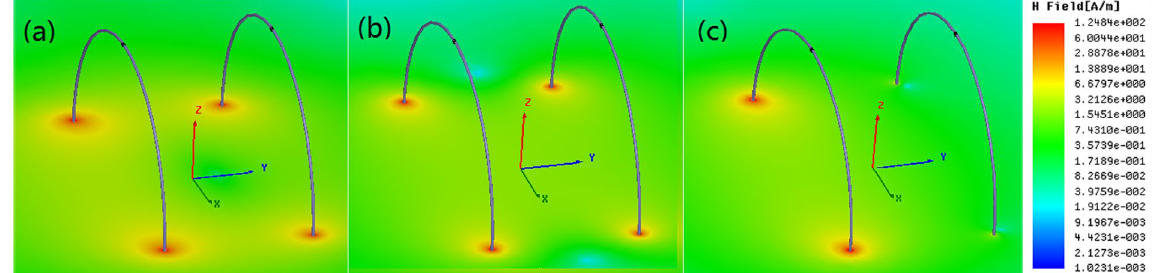
Figure 2. Incident and reflected magnetic field magnitude distributions. ( a ) The input port has a 10 Ω resistance, and the output has a 10 Ω inductive impedance. ( b ) The input port has a 10 Ω resistance, and the output has a 10 Ω capacitive reactance. ( c ) The input port has a 10 Ω resistance, and the output also has a 10 Ω resistance. The left and right coils are the transmitting and receiving coils, respectively. The black spots on the left and right of the coils are the input and output ports, respectively.